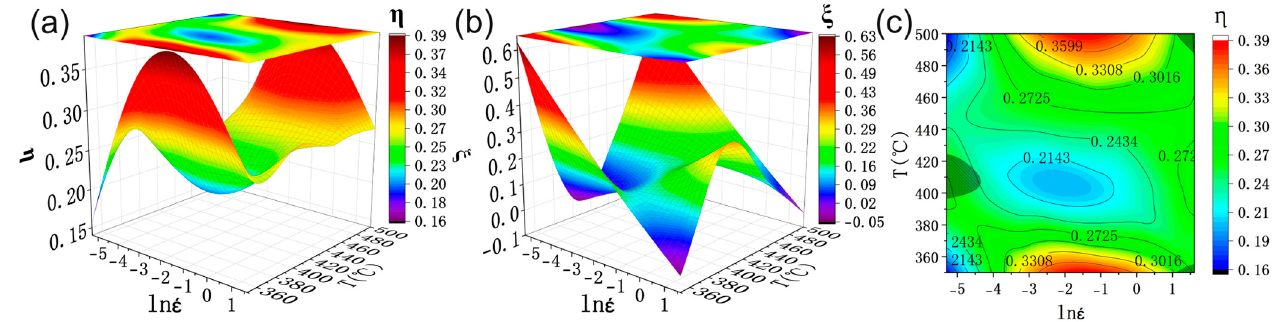
Figure 5. Processing diagram at peak stress: ( a ) power dissipation 3D map; ( b ) instability map; ( c ) processing map.